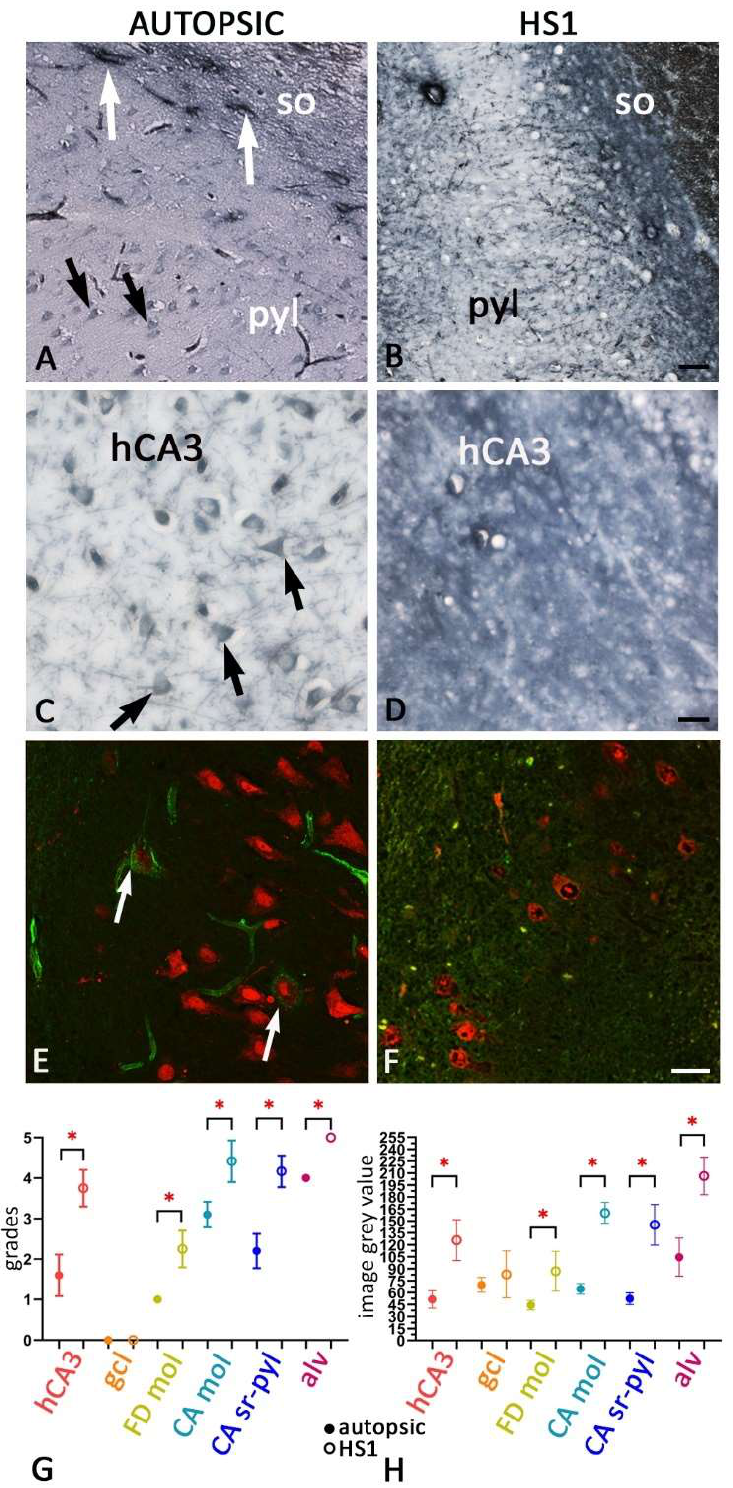
Figure 6. Changes in glycosylation patterns of ECM in HS1 shown by WFA staining (peroxidase and immunofluorescent labeling). The WFA staining of autopsic ( A , C , E ) and HS1 ( B , D , F ) hippo- campal sections. In autopsic hippocampus ( A , C , E ), WFA positive PNN are seen around pyramidal neurons in the CA fields (arrows in ( C , E )) and around non-pyramidal neurons, presumably PV in- terneurons in the CA1 stratum oriens (so, arrows in ( A )). In HS1 subjects, there are only sporadically solitary PNN in the so, and a loss of pyramidal and non-pyramidal WFA-positive PNN (in other fields ( B , D , F ). An intense WFA staining of diffuse ECM is present in all hippocampal fields, most prominently in the alveus and the perforant pathway. A significant difference in WFA staining is seen between controls and HS1 across all hippocampal fields, with the positivity being more pro- nounced in HS1, inspected both by observers’ estimation ( G ) and using automated image analysis